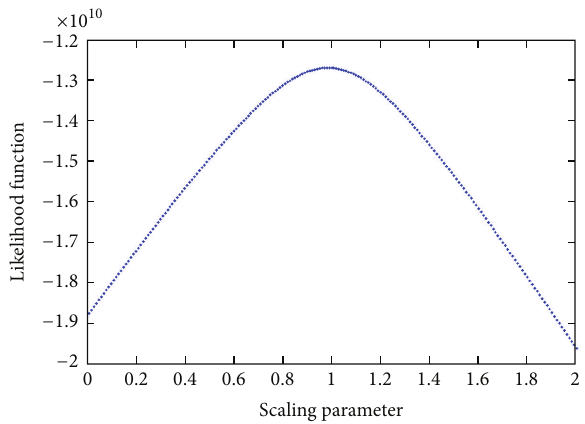
Figure 7: Likelihood function under different scaling parameters.